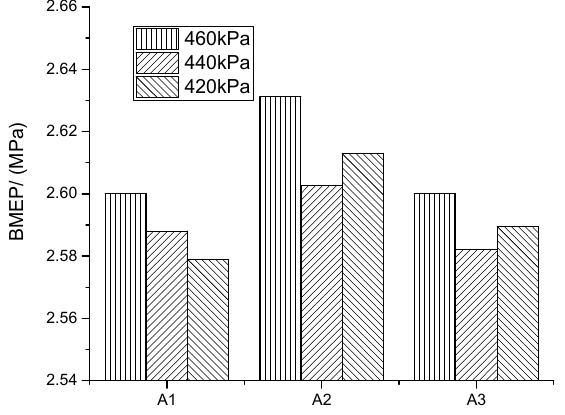
Figure 4. Power comparison under three inlet pressures for different combustion chambers.